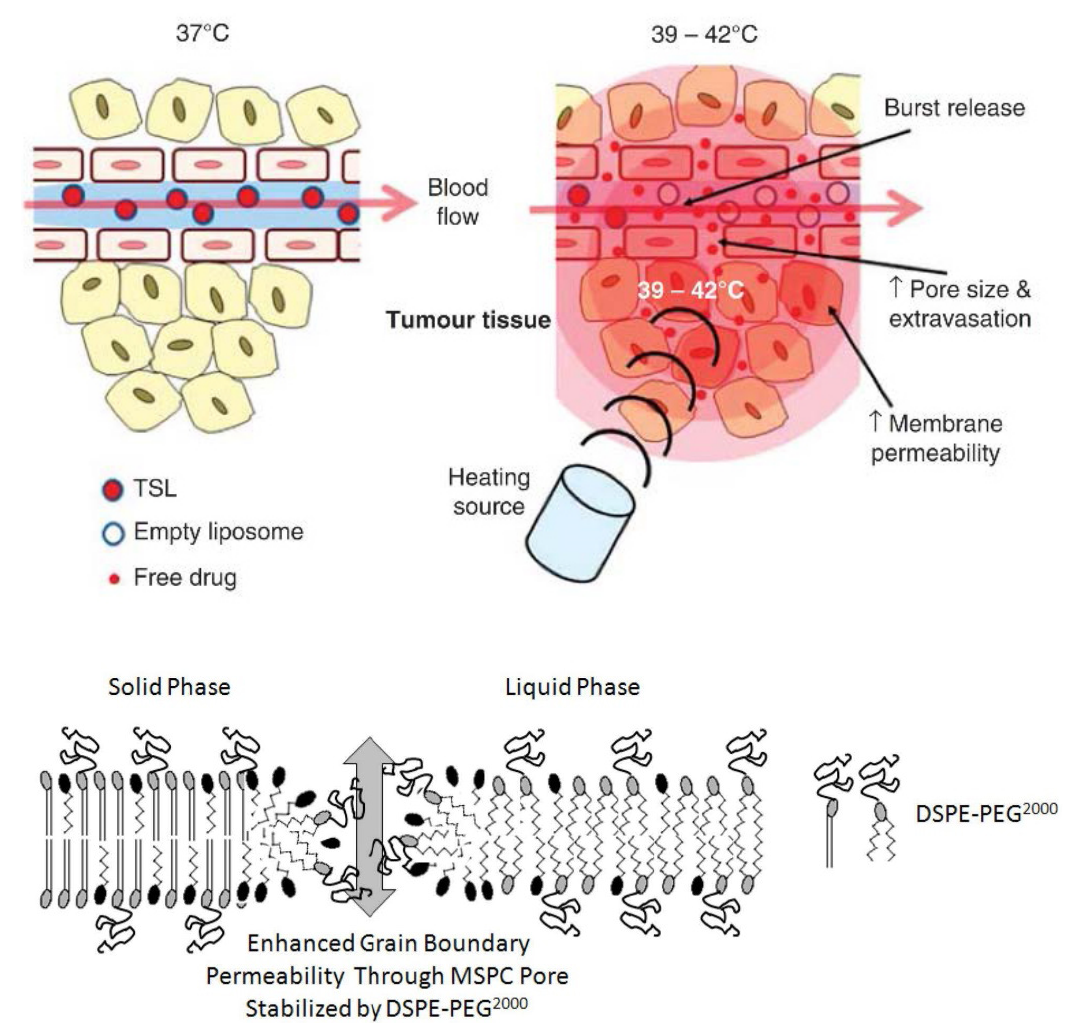
Figure 28. Application of lipid vesicles as temperature-sensitive drug delivery systems. Top : Schematic representation of the general concept for the use of temperature-sensitive liposomes (TSLs), as described by May and Li (2013) [412]. Mild hyperthermia ( T = 39–42 ◦ C) induced by a heating source at the site of the tumor can trigger the burst-release of anti-cancer drug molecules from administered TSLs. This creates high local concentrations of the drug within the tumor vasculature, promoting extravasation into the tumor. The hyperthermia also increases the permeability of the tumor cell membrane (possibly supported by the release of membrane-active components from the TSLs), which leads to increased drug uptake by the tumor cells. Bottom: Illustration of the suggested effect the lyso-lipid stearoyl-lyso-PC (=mono-stearoyl- phosphatidylcholine = MSPC) present in the TSL ThermoDox ® (together with DPPC and DSPE-PEG2000) is thought to have at elevated temperature on the liposome permeability towards the entrapped anti-cancer drug doxorubicin, as published by Landen et al. (2011) [411]. At T ~ T m , MSPC accumulates between the rigid, solid-ordered ( s o ), and fluid, liquid-disordered ( l d ), domains (at the “grain boundaries”) and forms pores due to the micelle-forming propensity of MSPC in its fluid state. Such pore formation explains the rapid release of doxorubicin from the liposomes once T = T m is reached. The schematic drawings of DSPE-PEG2000 illustrates the two temperature-dependent physical states of this amphiphile, “ordered” and “fluid”. Reproduced from [412], copyright © Taylor and Francis, 2013; and with permission from [411], Bentham Open,